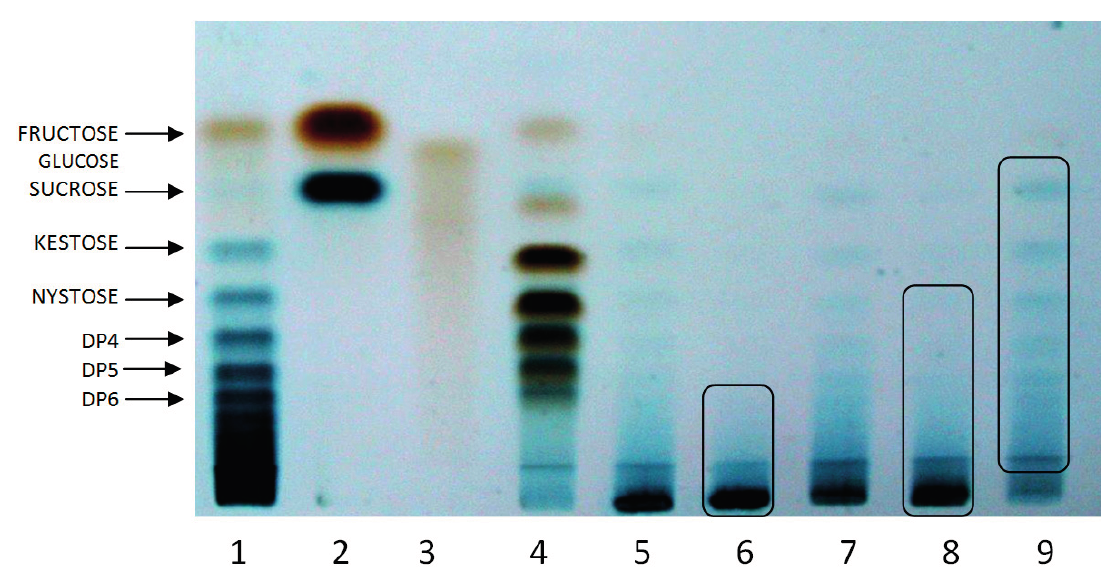
Figure 1. Thin Layer Chromatography (TLC) of Agave Fructose Fractions (AFF): 1 Chicory inulin, 2 Fructose + Sucrose, 3 Glucose, 4 FOS 2–7 DP, 5 PAFE, 6 retentate 3 KDa (AFF1), 7 Permeate 3 KDa, 8 retentate 1 KDa (AFF2) and 9 permeate 1 KDa (AFF